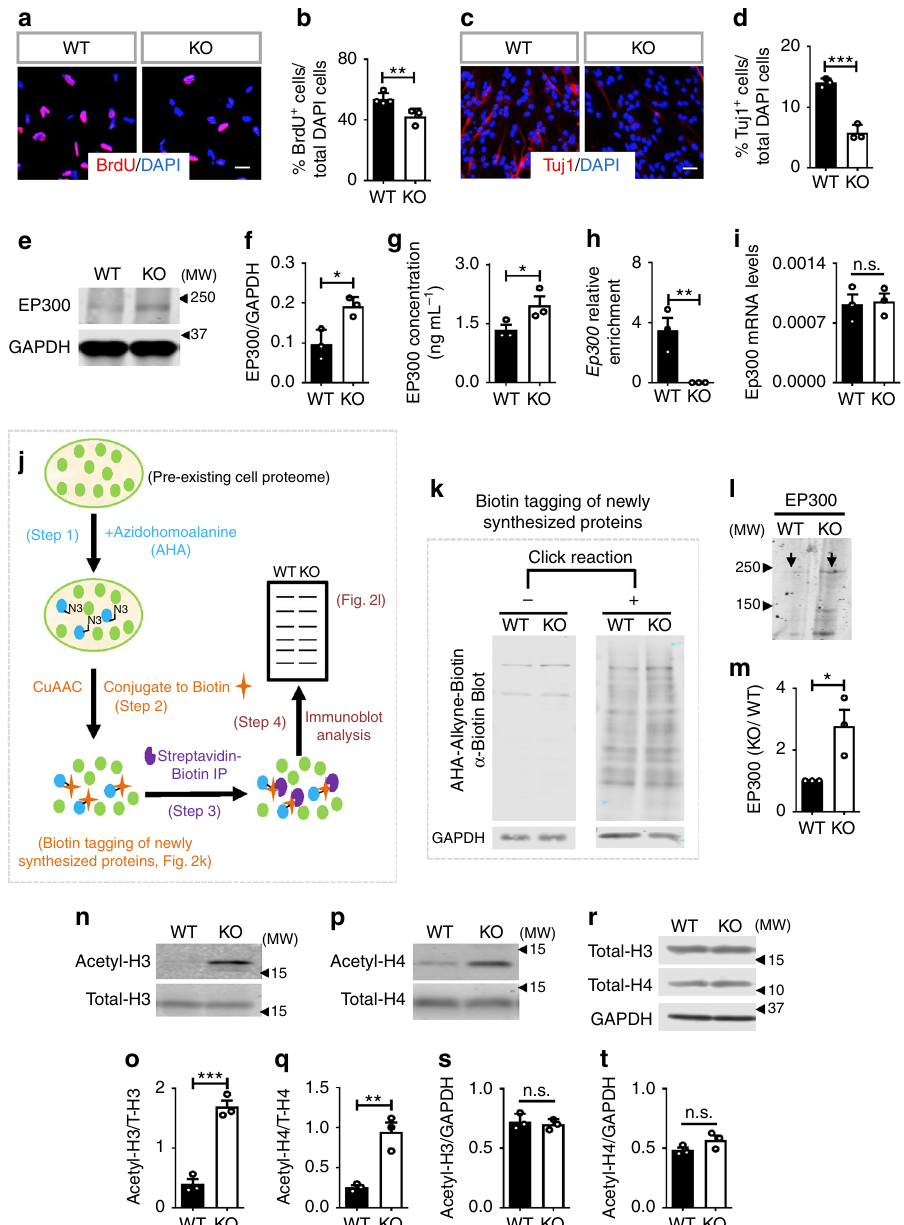
Fig. 2 FMRP controls EP300 protein synthesis in NPCs of 6-month old mice. a , b Fmr1 KO 6-mo NPCs exhibited reduced proliferation compared to WT NPCs as assessed by incorporation of the thymidine analog, BrdU ( a , red, BrdU; blue, DAPI. scale bar, 20 µ m) and quantitative analysis ( b , n = 3 – 4). c , d Fmr1 KO 6-mo NPCs differentiated into fewer neurons compared to WT NPCs as assessed by a neuronal marker Tuj1 + ( c , red, BrdU; blue, DAPI. scale bar, 20 µ m) followed by quantitative analysis ( d , n = 3). e , f Western blot analyses of EP300 protein expression levels in WT and Fmr1 KO 6-mo NPCs, ( n = 3). GAPDH was used as a loading control. g ELISA analyses of EP300 protein levels in WT and Fmr1 KO 6-mo NPCs ( n = 3). h RNA-IP-qPCR analysis showing FMRP was associated with Ep300 mRNA in NPCs ( n = 3). i Quantitative real-time PCR analyses showing no signi fi cant differences in Ep300 mRNA levels between WT and Fmr1 KO 6-mo NPCs ( n = 3). j Work fl ow for detection and identi fi cation of newly synthesized proteins using BONCAT (bio- orthogonal non-canonical amino acid tagging). k Visualization of Biotin-tagged, newly synthesized proteins in WT and Fmr1 KO NPCs using Biotin blot. l , m Sample western blot (upper panel) and quantitative analysis (lower panel, n = 3) of newly synthesized EP300 protein in WT and Fmr1 KO NPCs as determined by using BONCAT. n – q Western blot analyses of acetylation of histone H3 ( n , o ) and H4 ( p , q ) in WT and Fmr1 KO 6-mo NPCs ( n = 3). Total histone H3 or H4 was used as a loading control for acetylation of histones. r – t Western blot analyses of total histone H3 and H4 levels in WT and Fmr1 KO NPCs ( n = 3). GAPDH was used as a loading control. * P < 0.05, ** P < 0.01, *** P < 0.001. n.s.: no signi fi cant difference. Student ’ s t -tests were used for data analyses. Data are presented as mean ±